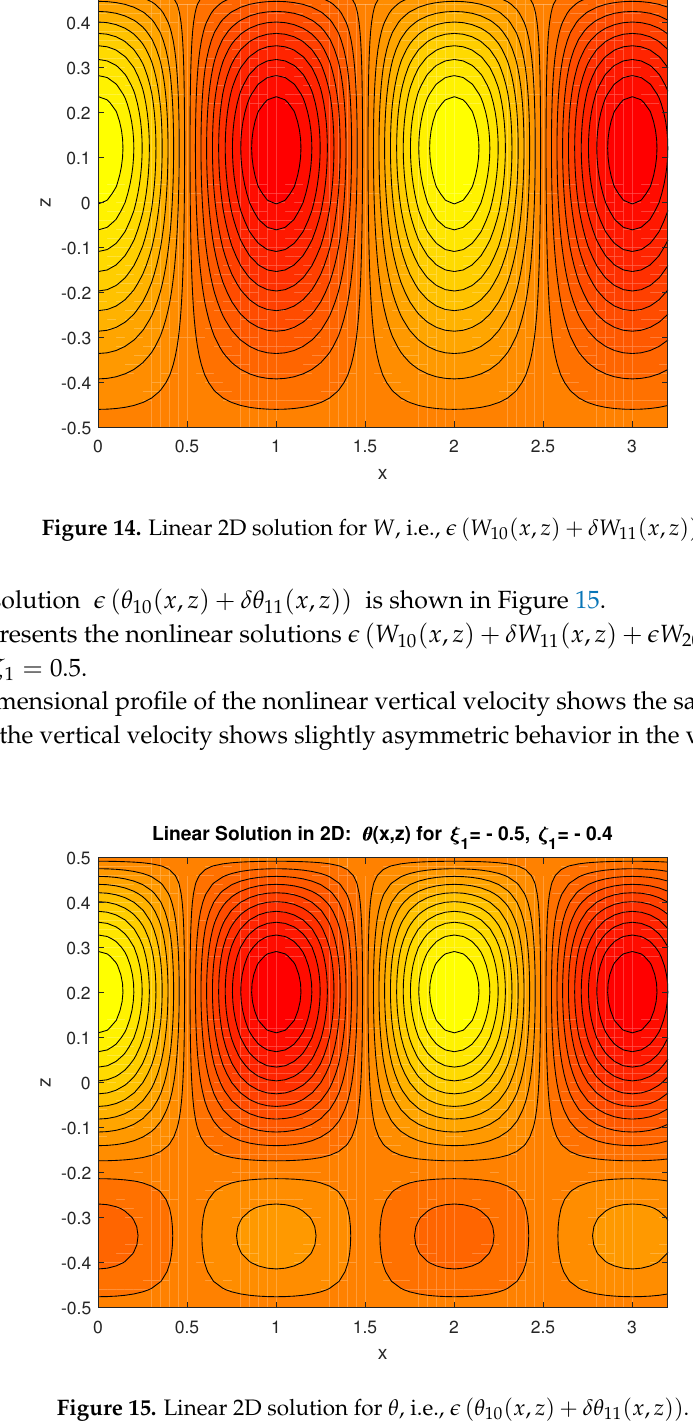
Figure 15. Linear 2D solution for θ , i.e., (cid:101) ( θ 10 ( x , z ) + δθ 11 ( x , z ))